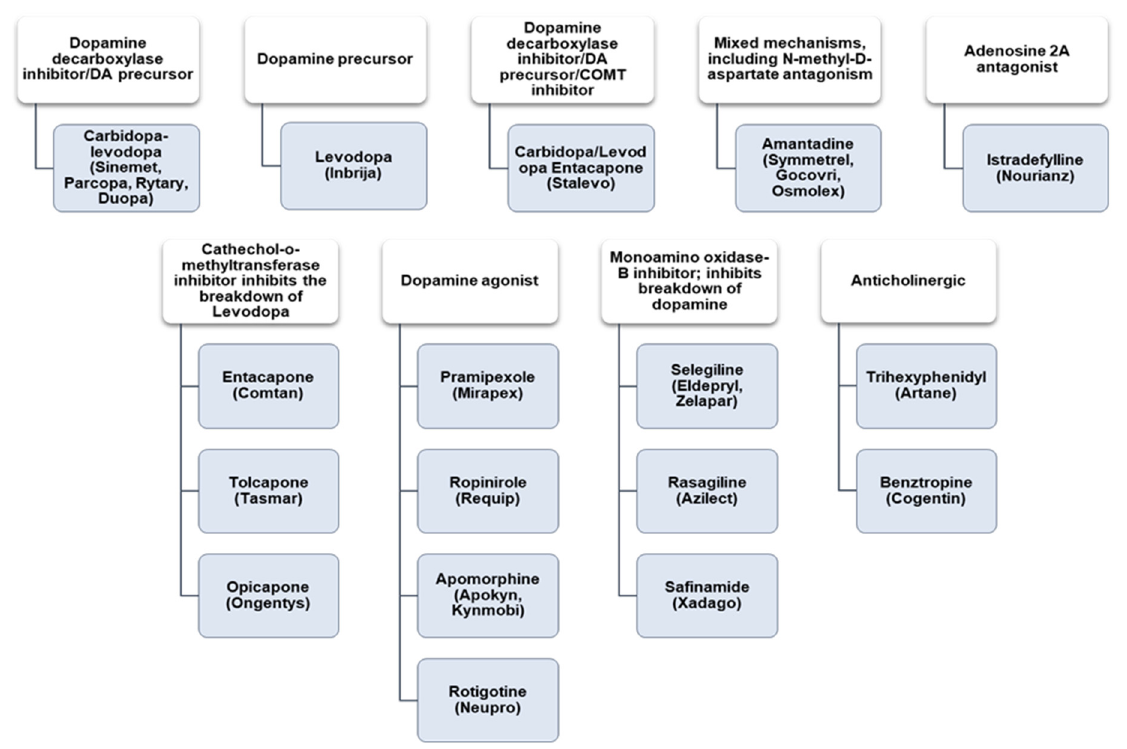
Figure 1. Commonly used drugs (shaded) are grouped with their functions (white) and PD therapeutics. Adapted from [33].